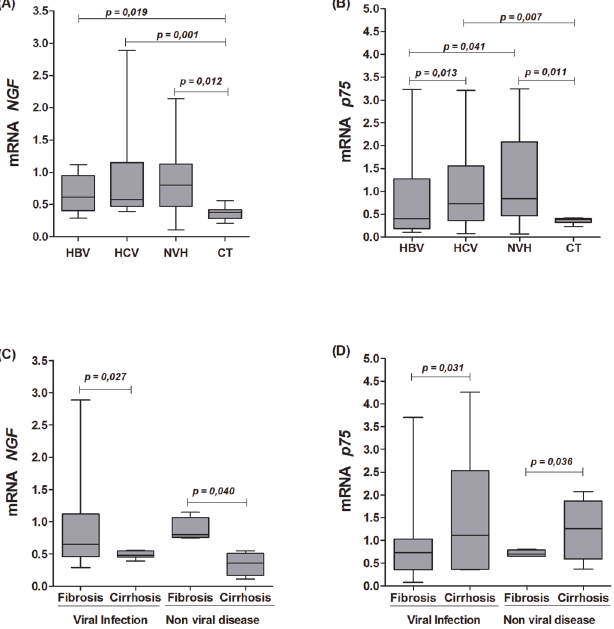
Fig 1. mRNA levels of NGF in the liver tissues. A: mRNA levels of NGF in the liver tissues of subgroups with HBV, HCV and NVH and the Control group (CT). B: mRNA levels of p75 NTR in the liver tissues of subgroups with HBV, HCV and NVH and the Control group (CT). C, D: mRNA levels of NGF and p75 NTR between the groups with hepatic fibrosis and cirrhosis due to viral and non-viral